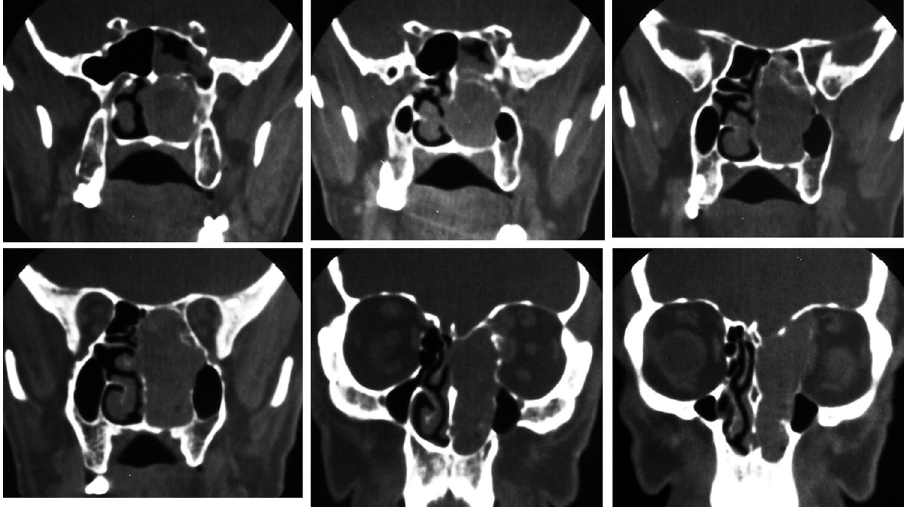
Figure 3 Naso-ethmoid neurofibroma: coronal computed tomography with soft tissue window, showing a naso-ethmoidal solid mass with medial orbital wall remodeling.